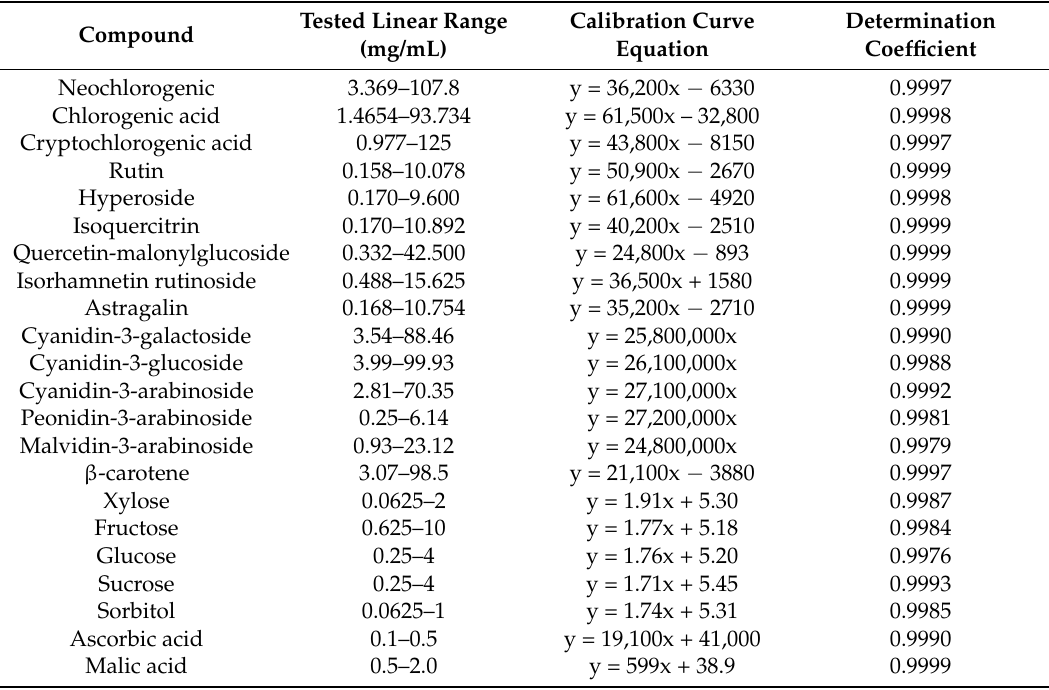
Table 6. Parameters of calibration curves of standard